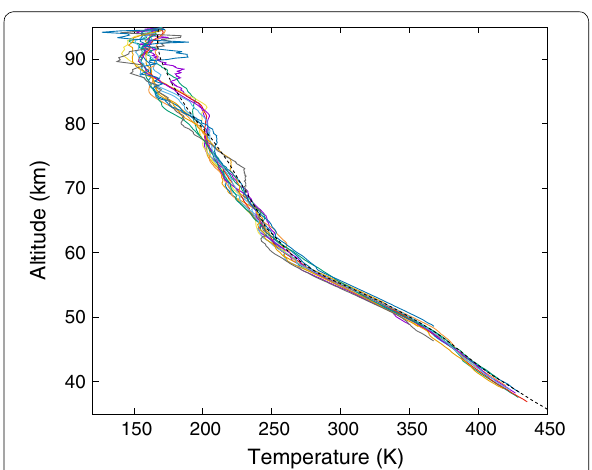
Fig. 6 Temperature profiles obtained by the radio occultation experi‑ ments. The VIRA temperature profile for the low latitude (< 30°) is also plotted by a dashed curve for comparison. The radius of Venus is assumed to be 6051.8